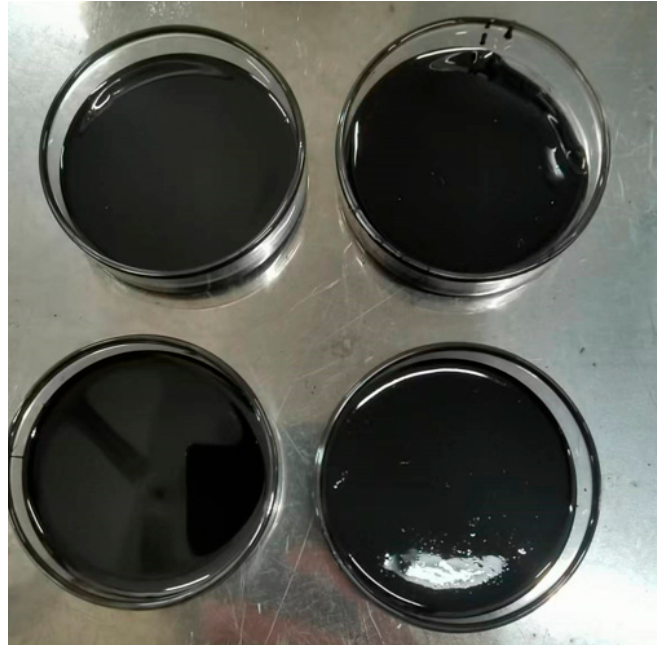
Figure 2. asphalt before UV aging. Figure 2. Asphalt before UV aging.